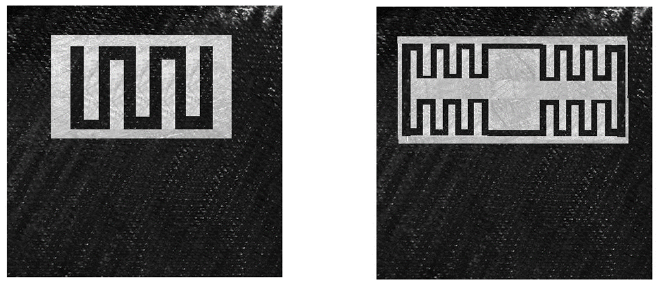
Figure 7. Inherent concept system for failure detection.